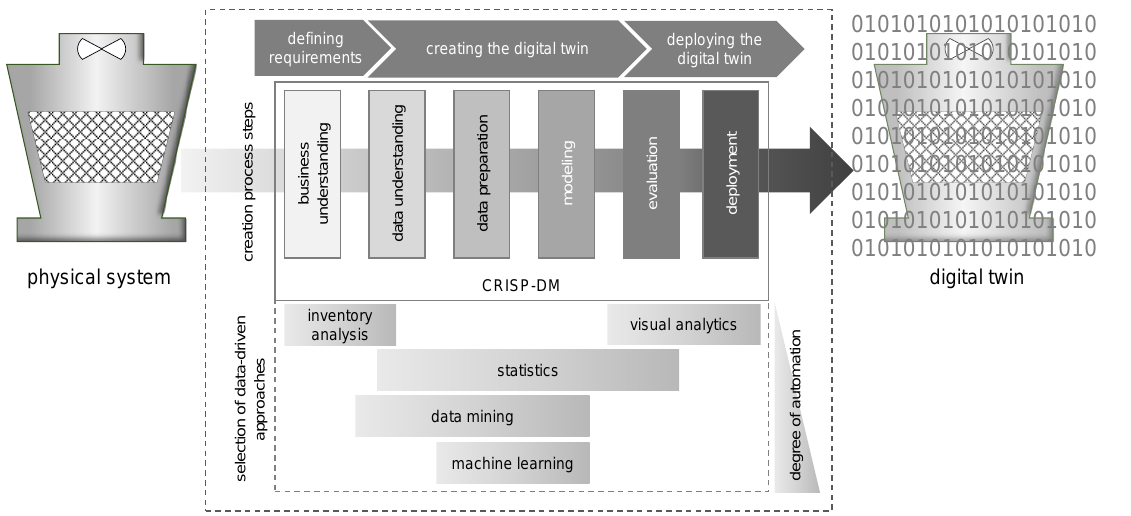
Figure 2. Data-driven approaches and proposed workflow to create a digital twin.